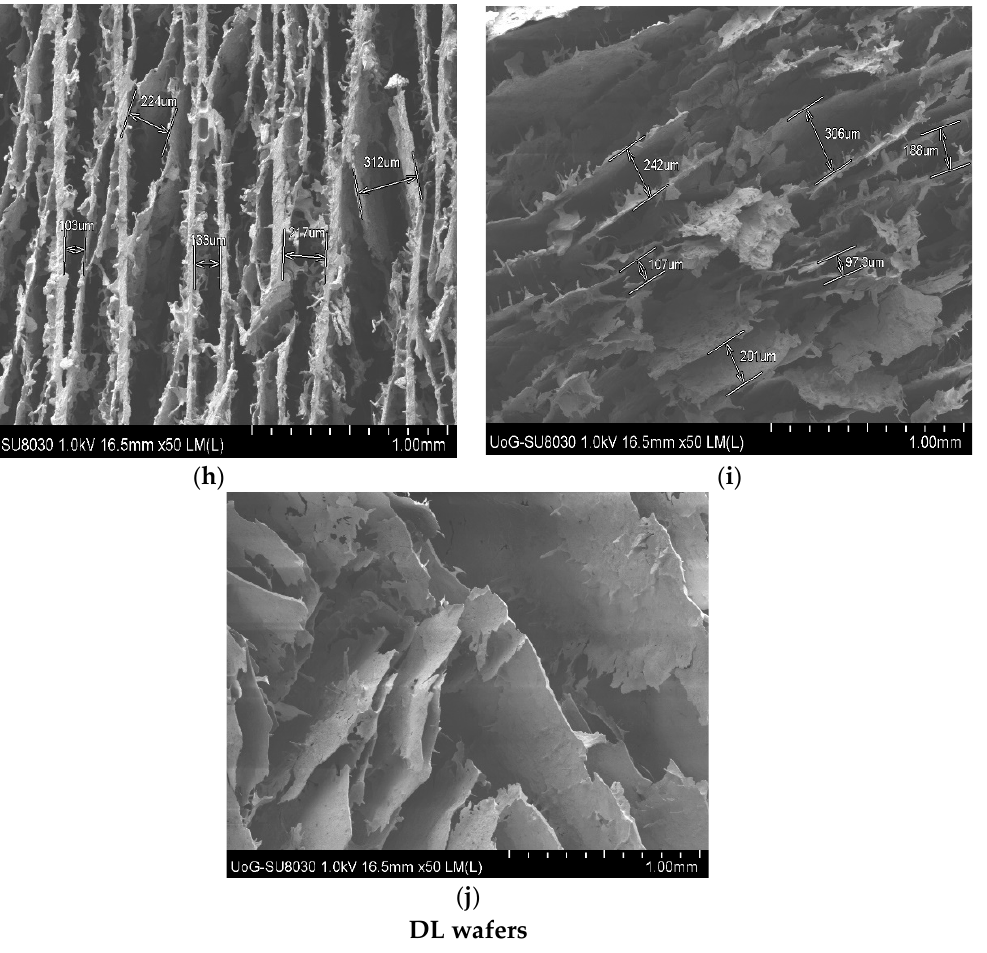
Figure 4. Representative SEM micrographs of optimized BLK and DL wafers. ( a ) W10; ( b ) W13; ( c ) W14; ( d ) W16; ( e ) W17; ( f ) W23; ( g ) W24; ( h ) W25; ( i ) W26; and ( j ) W27.